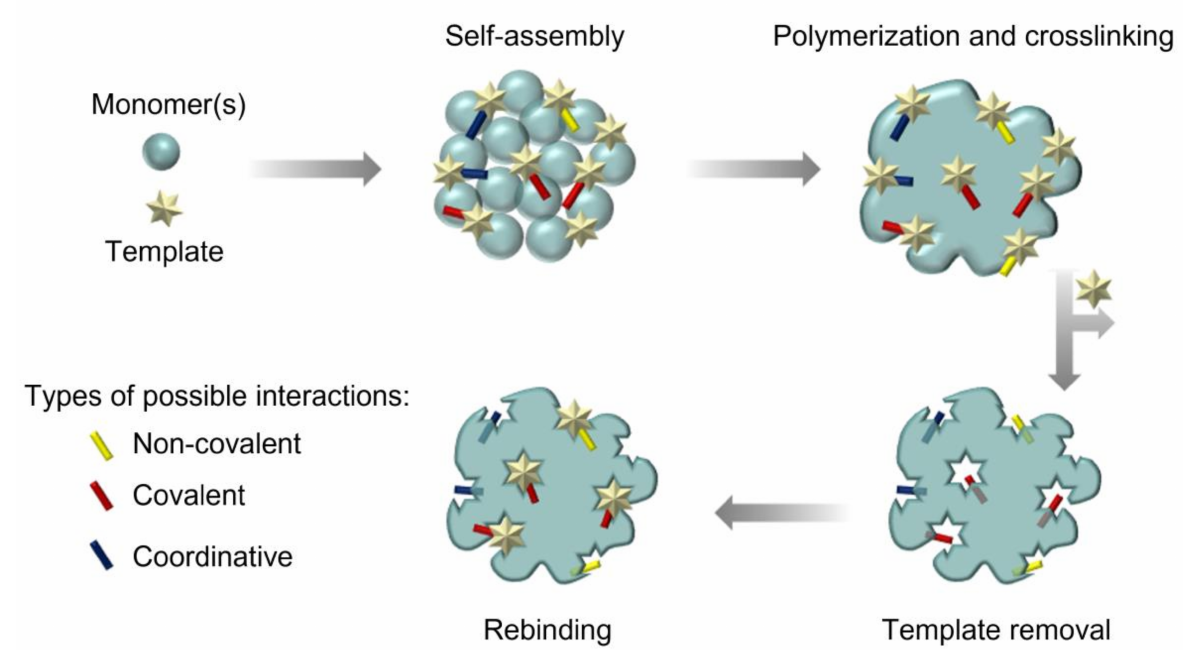
Figure 1. Schematic representation of MIP